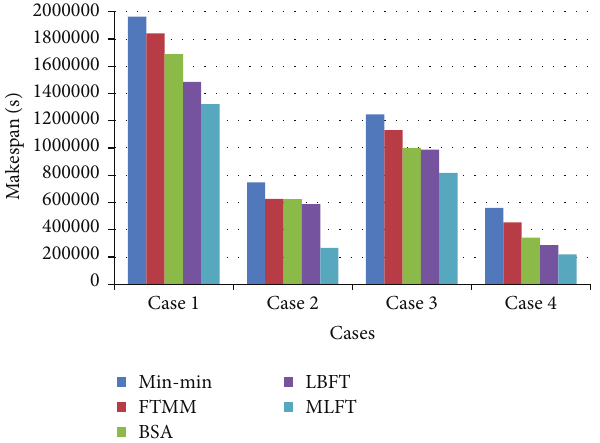
Figure 7: Performance based on resource utilization (%).